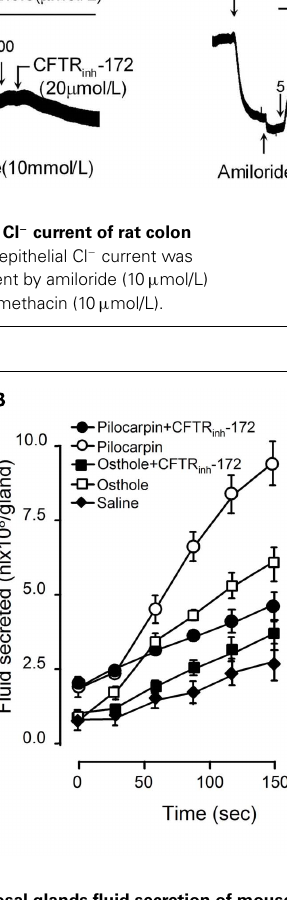
FIGURE 4 | Stimulation of submucosal glands fluid secretion of mouse trachea by osthole. (A) Bright field micrographs of expanding fluid droplets secreted from single submucosal glands. a, saline; b, osthole; c, osthole plus CFTR inh -172; d, pilocarpine; e, pilocarpine plus CFTR inh -172. (B) Linear volume increase of gland droplets (mean ± SE, n = 12) with time after